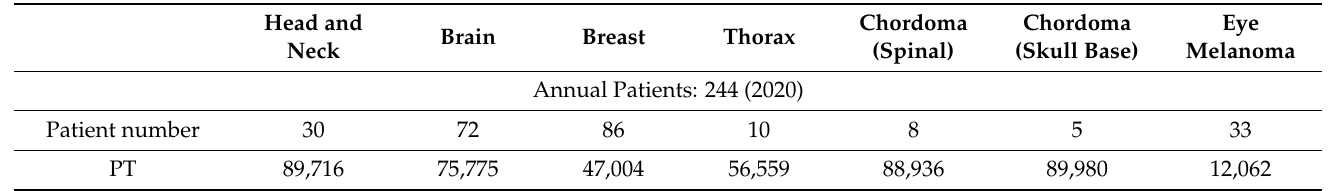
Table 5. Costs per PT course with short-term (2021), middle-term (till 2024) and long-term (after 2024) projections (in euros)